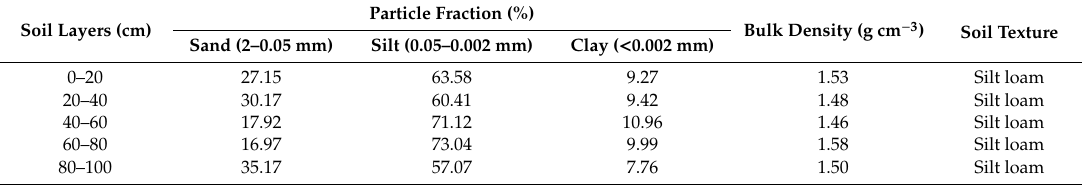
Table 2. Measured soil physical properties along the soil profile in the experiment site. Soil Layers